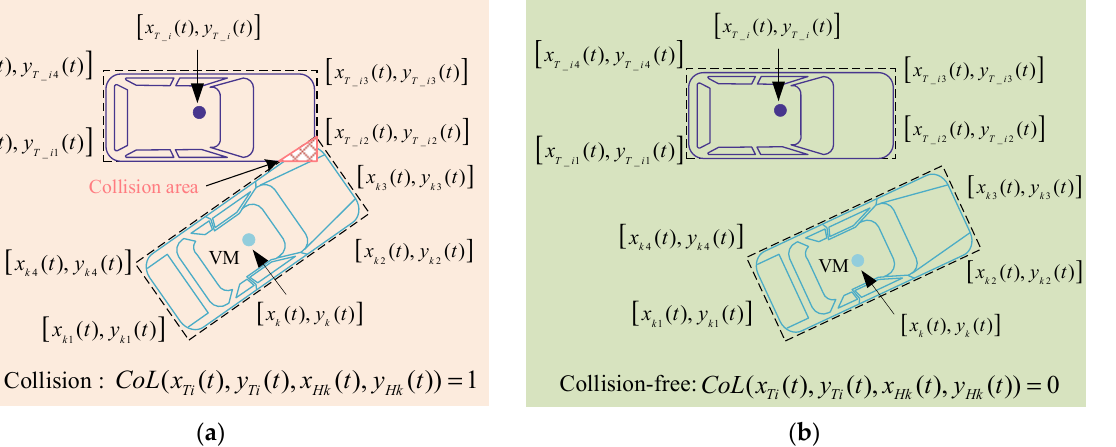
Figure 7. ( a ) Collision analysis scenarios; ( b ) Collision-free analysis scenarios. For the subject vehicle, when the following criteria are complied with, it proves that the vehicle traveling along the lane-changing trajectory cluster will not collide.